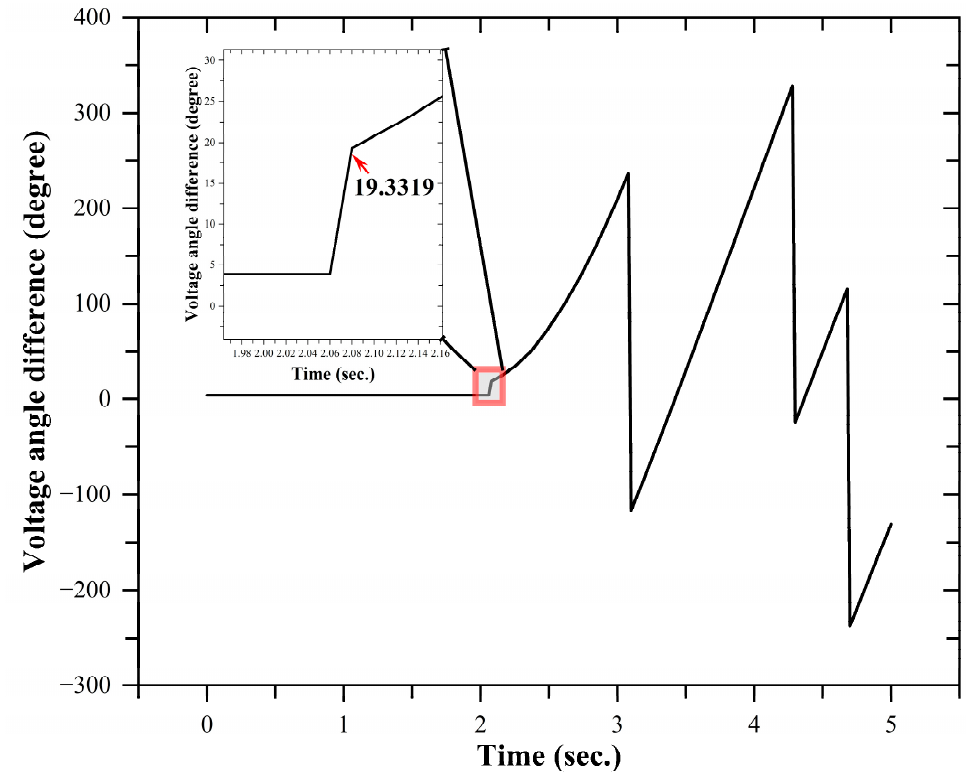
Figure 17. Proposed unintentional island threshold technique for over frequency Scenario 3.